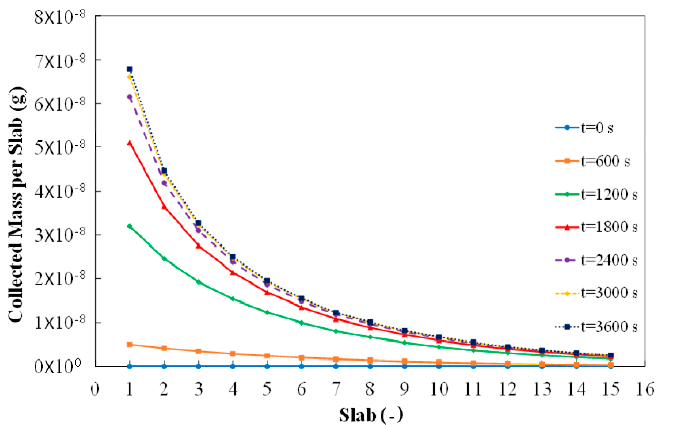
Figure 8. Collected soot mass in each slab versus time.